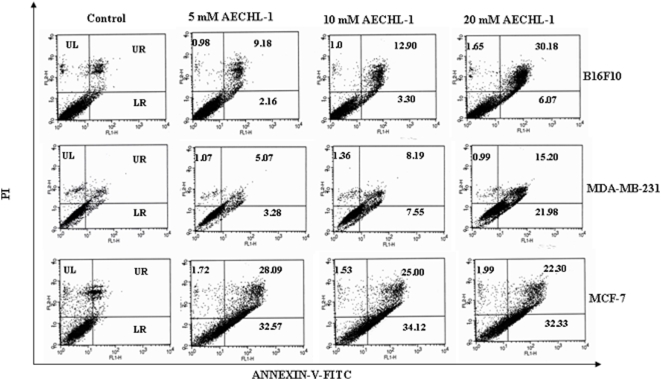
Effect of AECHL-1 on apoptosis of tumor cells.Detection of apoptosis was done by the Annexin V-FITC apoptosis detection
kit according to the manufacturer's instructions and then
analyzed by flow cytometry: UR indicates the percentage of late
apoptotic cells (Annexin V and PI positive cells), and LR indicates the
percentage of early apoptotic cells (Annexin V positive cells) The data
are presented in dot blots depicting annexin/fluorescein isothiocyanate
(x axis) vs. PI staining (y axis).
The percentage of cells in each quadrant is shown. The results are
representative of three independent experiments.